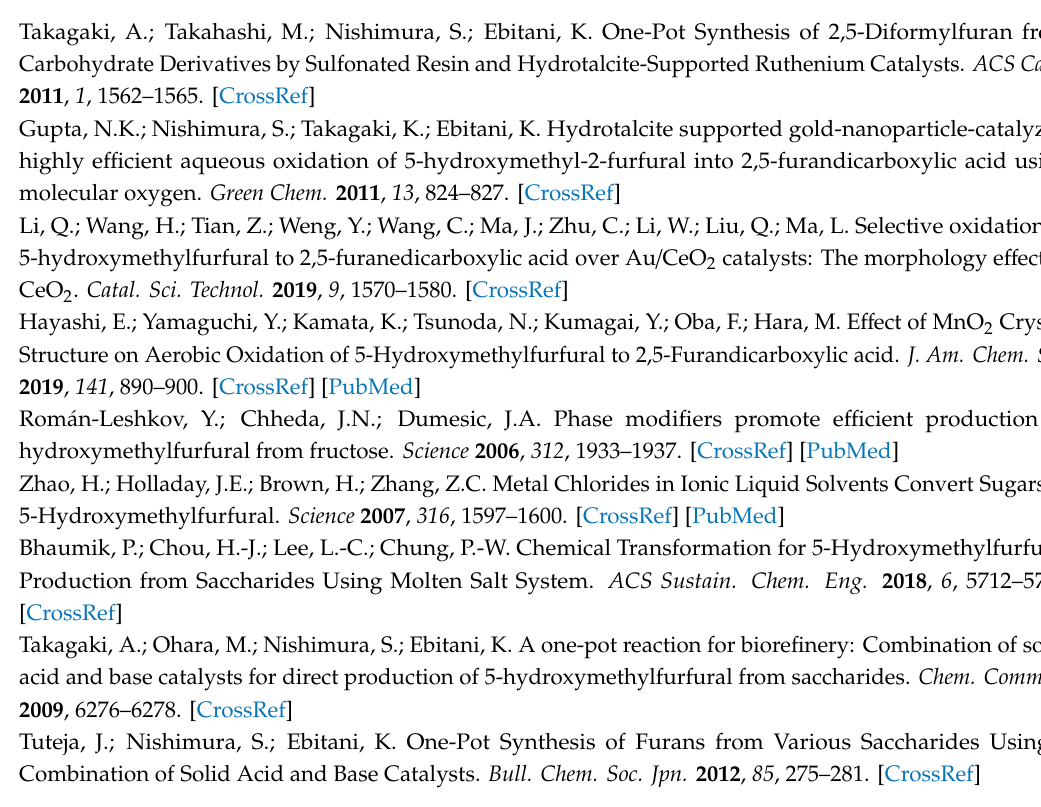
Figure S1: FTIR spectrum of pyridine adsorbed on HNbWO 6 aggregated nanosheets, Figure S2: Time course of HMF formation from glucose over HNbWO 6 aggregated nanosheets, Figure S3: Time course of HMF formation from fructose over HNbWO 6 aggregated nanosheets, Figure S4: XRD pattern of HNbWO 6 aggregated nanosheets after the reaction, Table S1: Rate constants (units in h -1 ) used for a typical